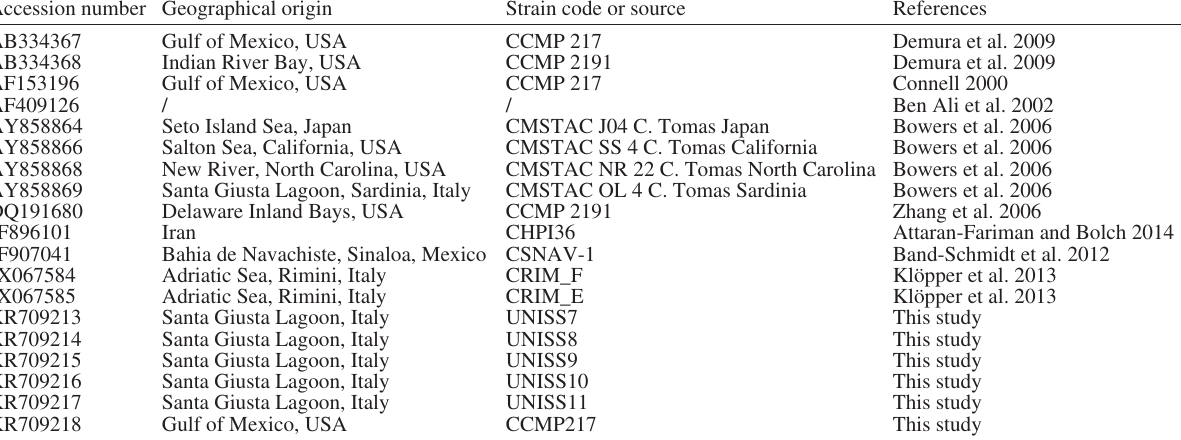
Table 4. – ITS-5.8S rDNA sequences obtained in this study and the sequences deposited at GenBank which showed a strong similarity with ours in the BLAST analysis.